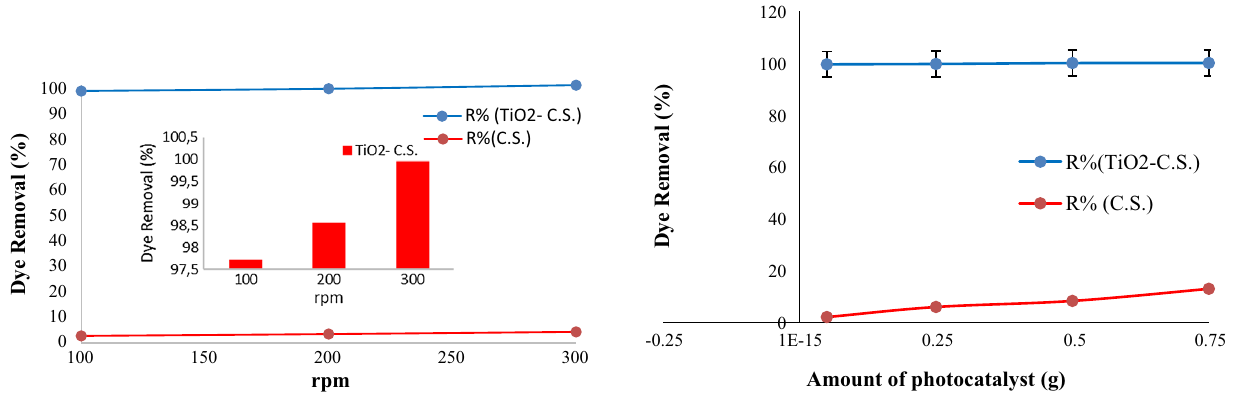
Fig. 10 Effect of the amount of photocatalyst on the photocatalytic removal rate of RB5 azo dye (pH 3.0, 25 °C, 300 rpm, 30